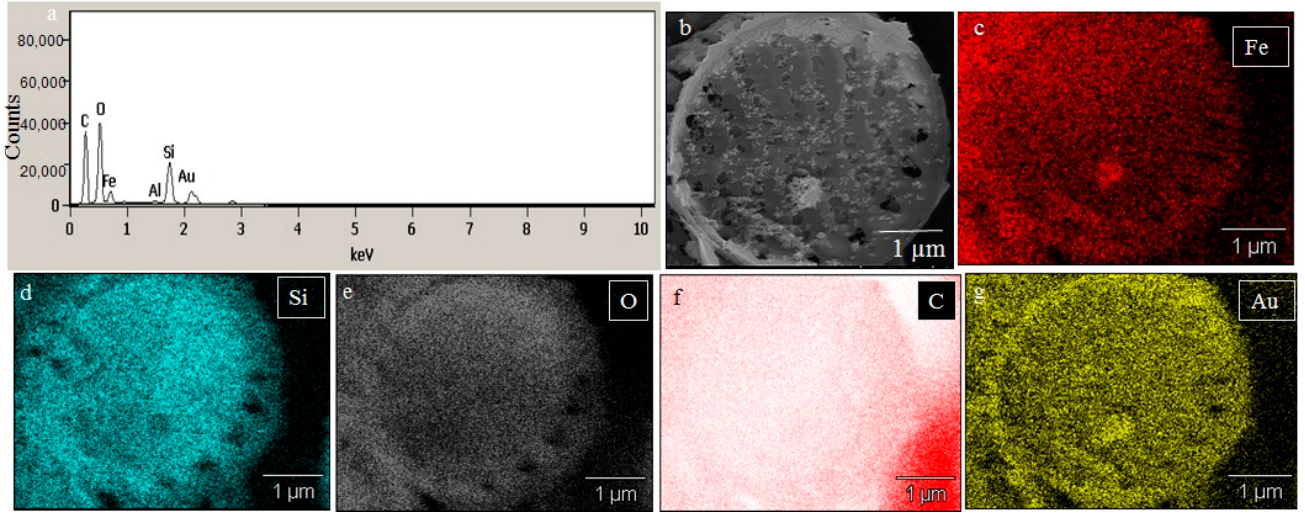
Figure 3. EDAX spectra of IONPs loaded frustules ( a ). Elemental mapping of IONPs loaded single frustules confirmed presence of iron, silicon and oxygen all over the frustules ( b – g ).